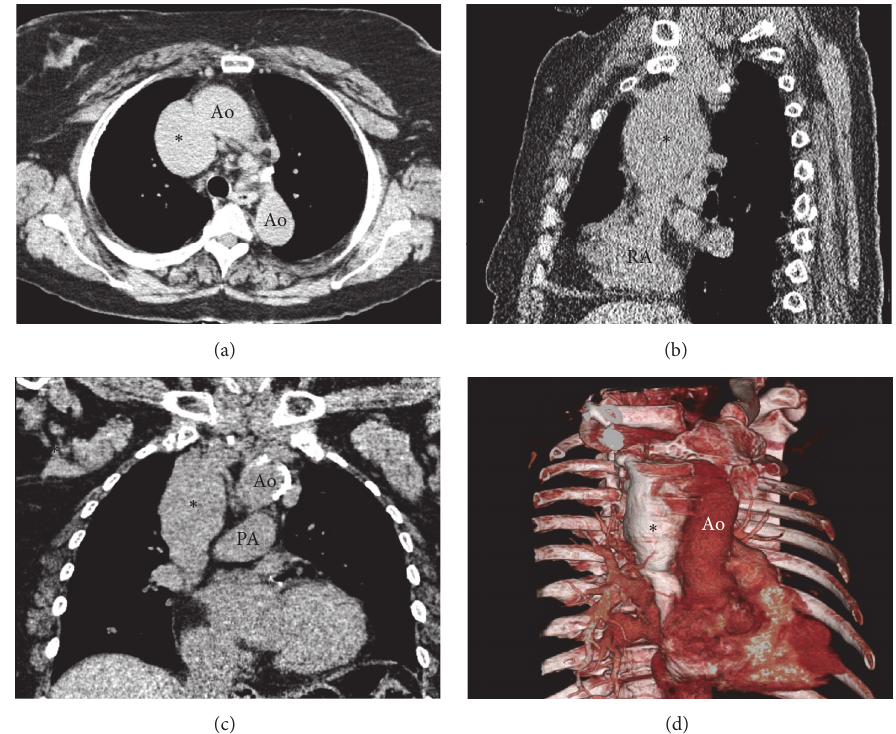
Figure 1: Axial (a), sagittal (b), and coronal (c) noncontrast CT images of the thorax demonstrating the SVC aneurysm ( ∗ ). (d) 3D reconstruction of the SVC aneurysm using CT of the thorax with IV contrast performed in 2014. Ao: aorta; PA: pulmonary artery; RA: right